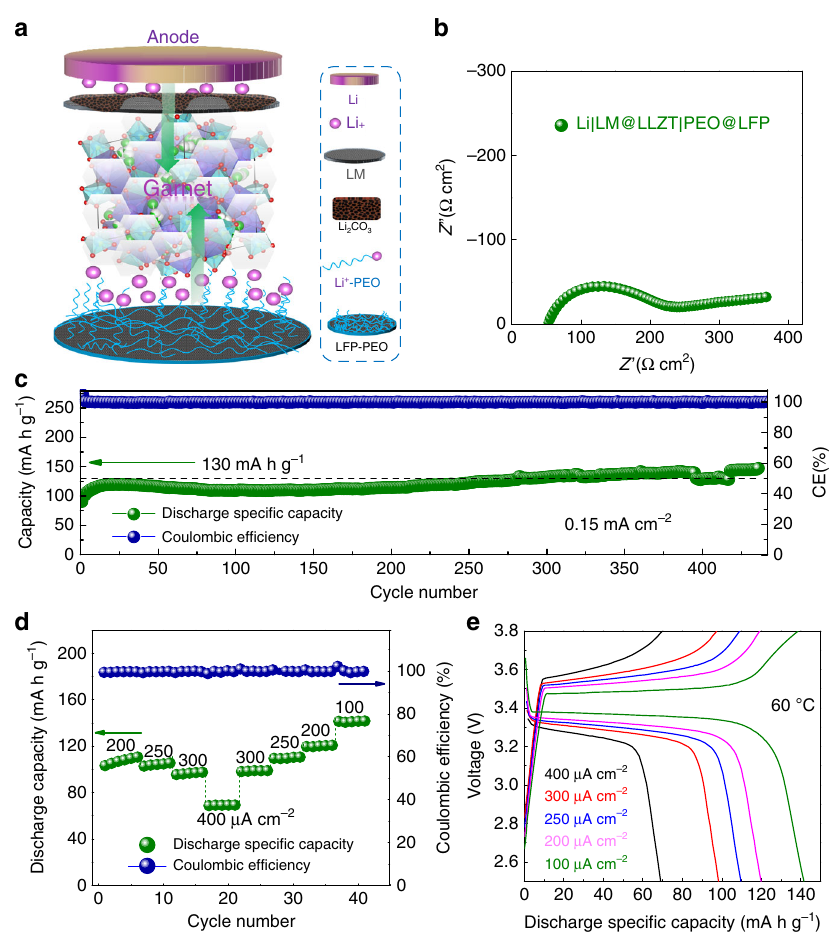
Fig. 6 Cycling performance of solid-state cells based on LiFePO 4 (LFP). a Structure schematic of Li|LM@LLZT|PEO@LFP solid-state cell. b EIS spectrum of fresh cell before cycling. c Cycling performance of solid-state cell at 0.15 mA cm − 2 . d Rate performance of solid-state cell at the current densities from 0.1 to 0.4 mA cm − 2 . e Voltage pro fi les of solid-state cell at different current densities from 0.1 to 0.4 mA cm − 2